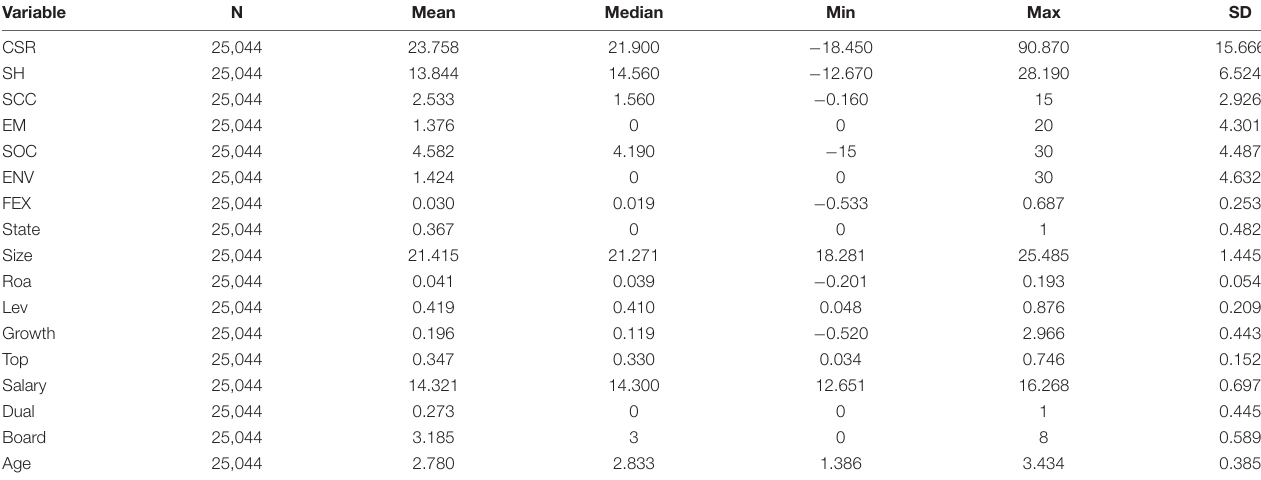
TABLE 1 | Descriptive statistics of variables.